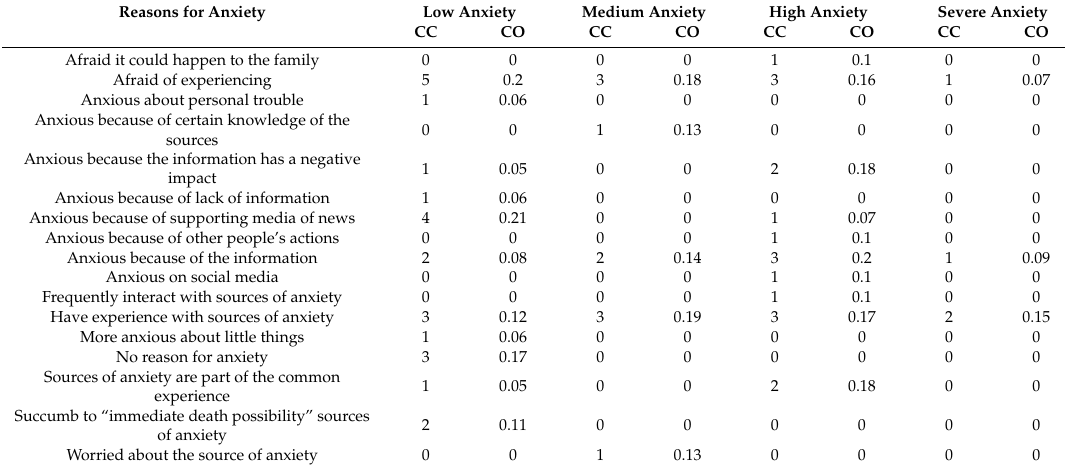
Table 19. Co-occurrences and reasons for anxiety.